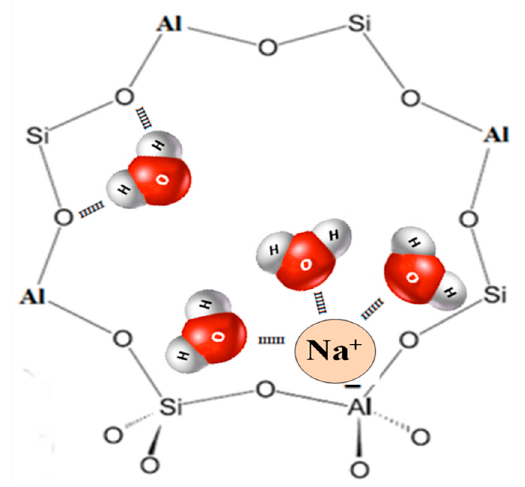
Figure 11. Water interactions into hydrophilic zeolites framework, example of LTA-type zeolite. Scheme representing the 8-membering aperture of the LTA-type zeolite, the elemental composition (Si, Al, O, cations) is homogeneous in all the crystal leading to the same adsorption properties.